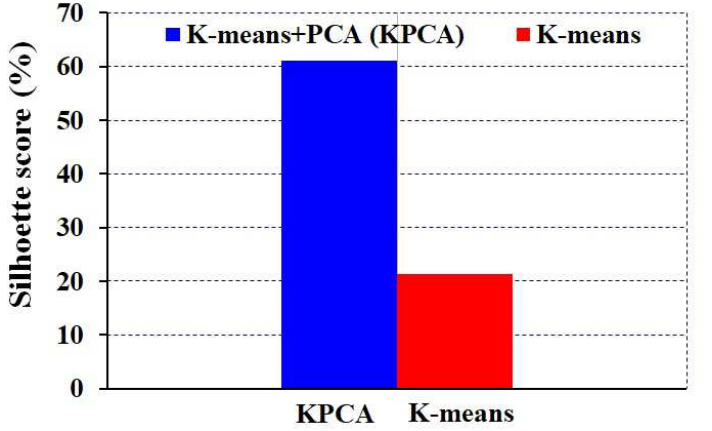
Figure 7. Silhouette score comparison between a combination of k-means and PCA and k-means.